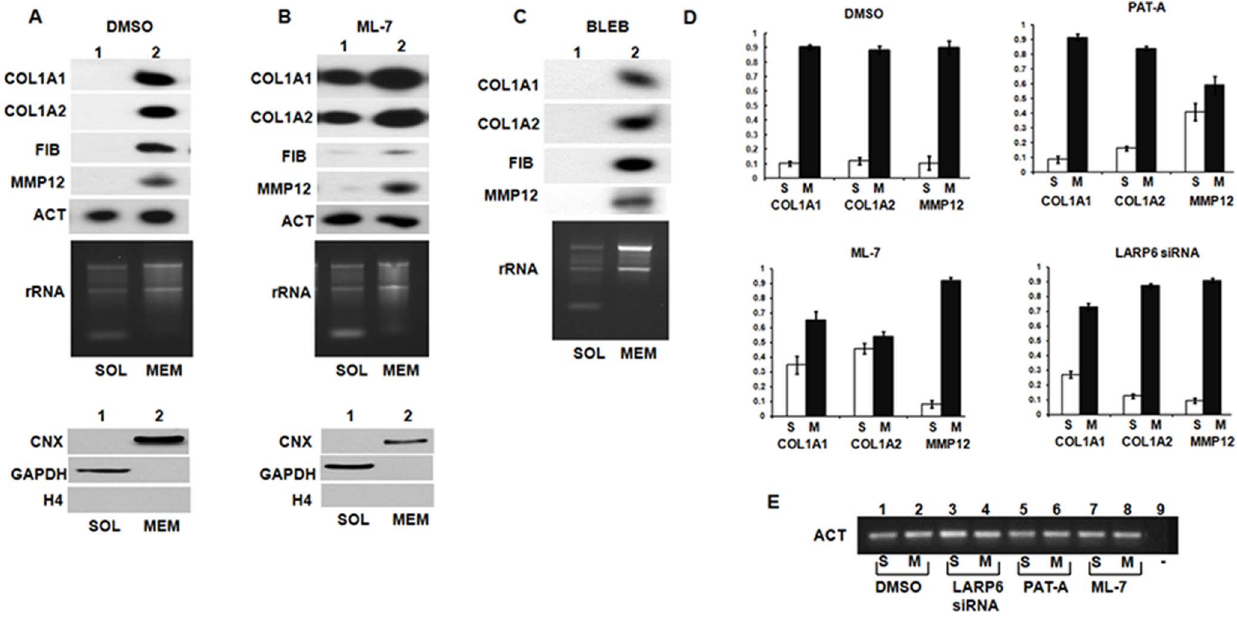
Figure 8. Membrane partitioning of collagen mRNAs after disruption of nonmuscle myosin. A. Partitioning of collagen mRNAs in control cells. Upper panel: HLFs were fractionated in cytosolic fraction (SOL, lane 1) or membrane fraction (MEM, lane 2) and collagen a 1(I) (COL1A1), collagen a 2(I) (COL1A2), fibronectin (FIB), matrix metalloproteinase 12 (MMP12) and actin (ACT) mRNAs were analyzed by RT-PCR. Distribution of ribosomal RNA (rRNA) is shown by agarose gel electrophoresis and ethidium bromide staining. Bottom panel: distribution of calnexin (CNX), GAPDH and histone H4 proteins in the fractions, analyzed by western blot. B. Partitioning of collagen mRNAs in ML-7 treated cells. Experiment as in A, except HLFs were treated with ML-7. C. Partitioning of collagen mRNAs in blebbistatin treated cells. Experiment as in A, except HLFs were treated with blebbistatin. D. Real time RT-PCR determination of collagen mRNAs. The treatment of HLFs is indicated above the panels. The cells were fractionated into cytosolic (S) and membrane (M) fractions, RNA was extracted and analyzed by real time RT-PCR for presence of collagen a 1(I) (COL1A1), collagen a 2(I) (COL1A2) and matrix metalloproteinase 12 (MMP12) mRNAs. The signals were normalized to actin mRNA, which was found in similar amounts in S and M fractions. The normalized expression of each mRNA in S and M fractions was summed up and arbitrarily set as 1. Bars represent the relative proportion of mRNAs in the fractions. Error bars: + - 1 SEM. E. Distribution of internal control actin mRNA. cDNA used in real time RT-PCR reactions in D was analyzed by PCR with primers specific for actin mRNA (ACT). Lanes 1 and 2, control cells, lanes 3 and 4, cells transfected with LARP6 siRNA, lanes 5 and 6, cells treated with Pat-A, lanes 7 and 8, cells treated with ML-7. Lane 9, control reaction without cDNA.